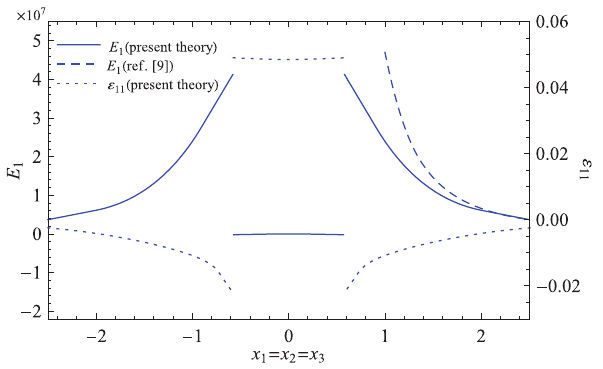
Figure 3 Periodic distribution of quadrangular InN QWRs within AlN barrier in the x x 1 2